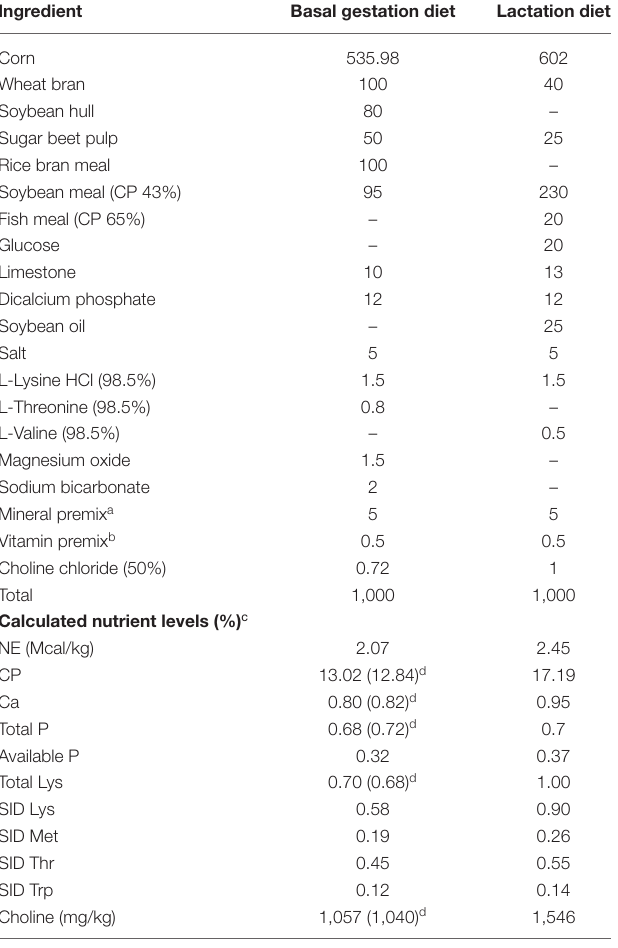
TABLE 1 | Composition and nutrient levels of gestation and lactation diets (as fed basis). Ingredient Basal gestation